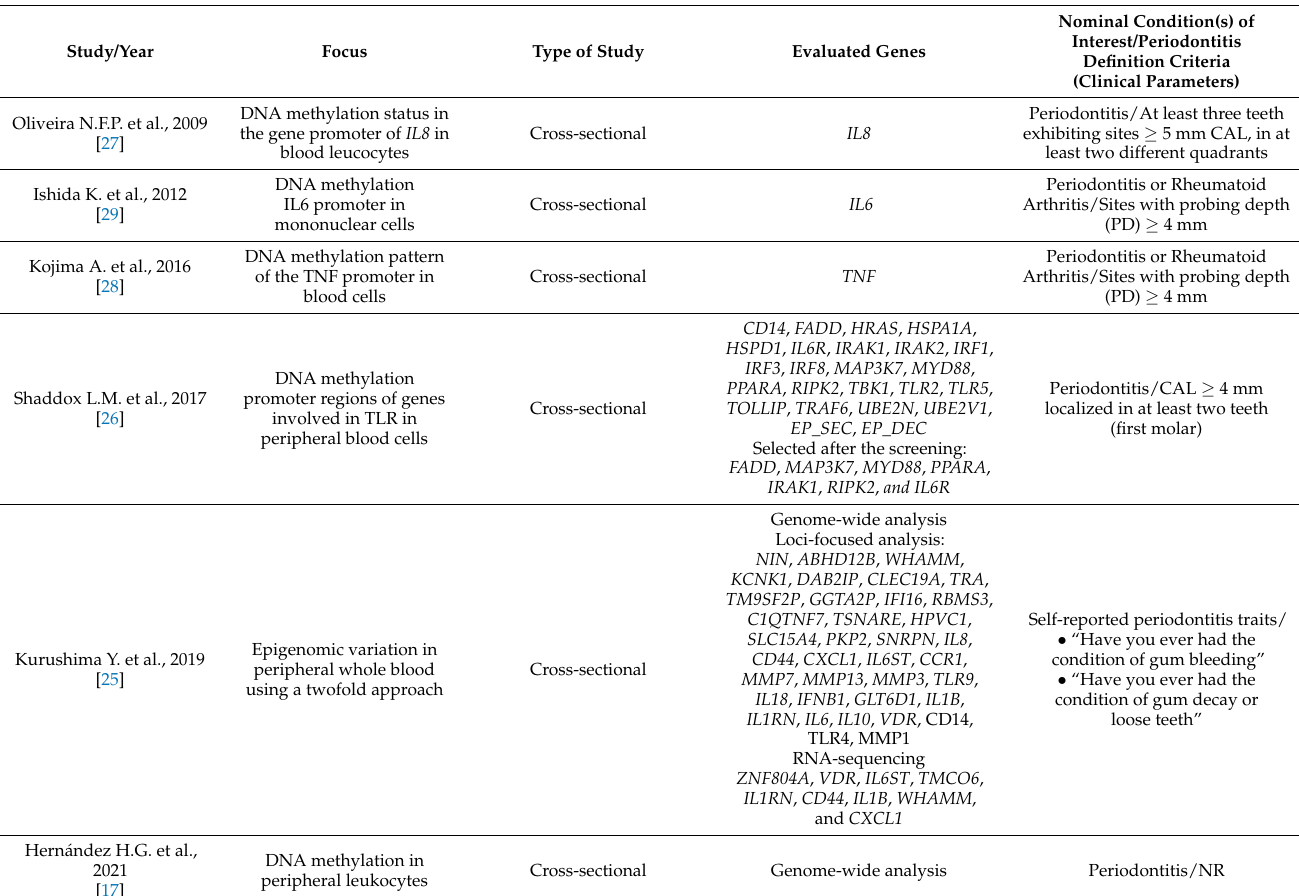
Table 2. Studies assessing peripheral blood leucocytes cells (PBLCs) differential DNA methylation and gene